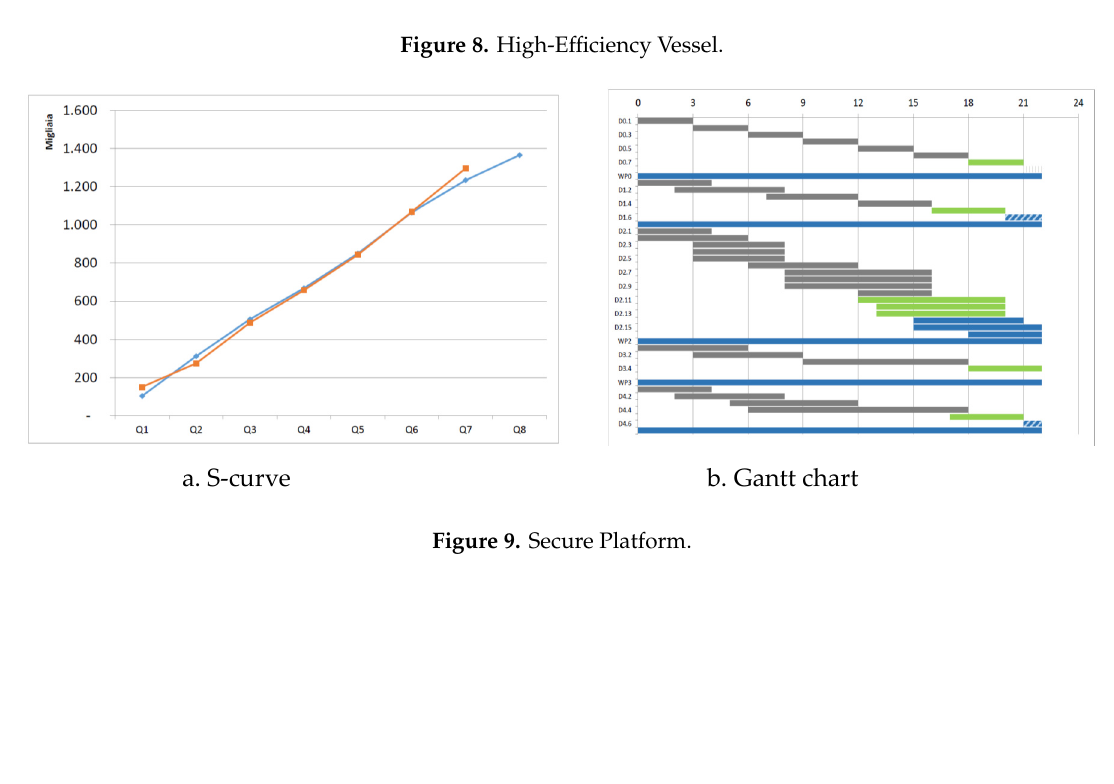
Gantt chart Figure 10. Platform for High-Efficiency Waste-to-Energy Thermo-Conversion (PiTER) on Board.